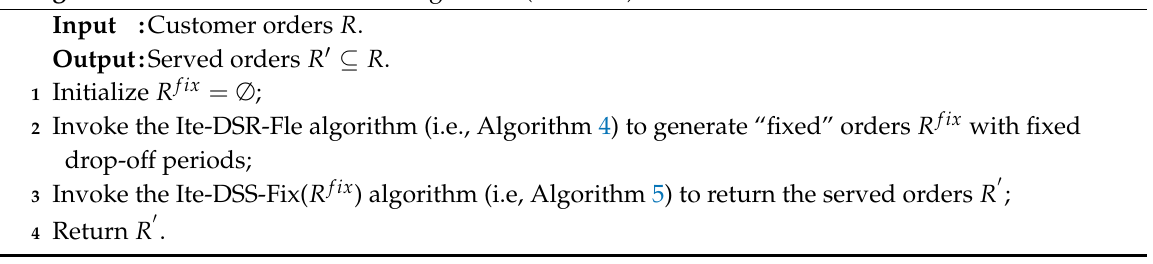
Algorithm 6: The DSS-Fle Variant Algorithm ( DSS-Fle